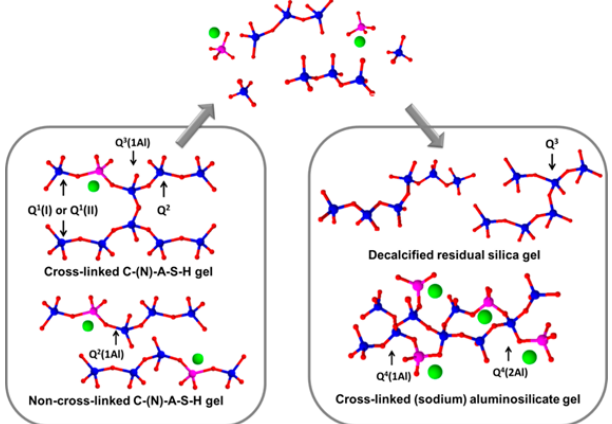
Figure 3. Structure change of slag-based AAMs during carbonation; blue balls: Si; pink balls: Al; red balls: O; green balls: Na [47].